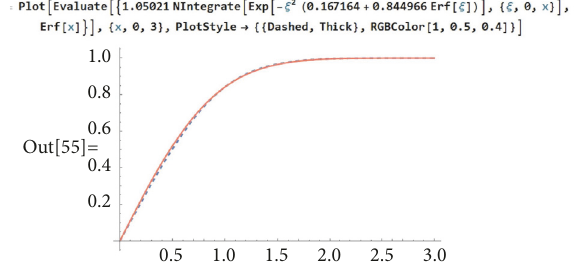
Figure 10: Adjusting the error function by means of the new special function.